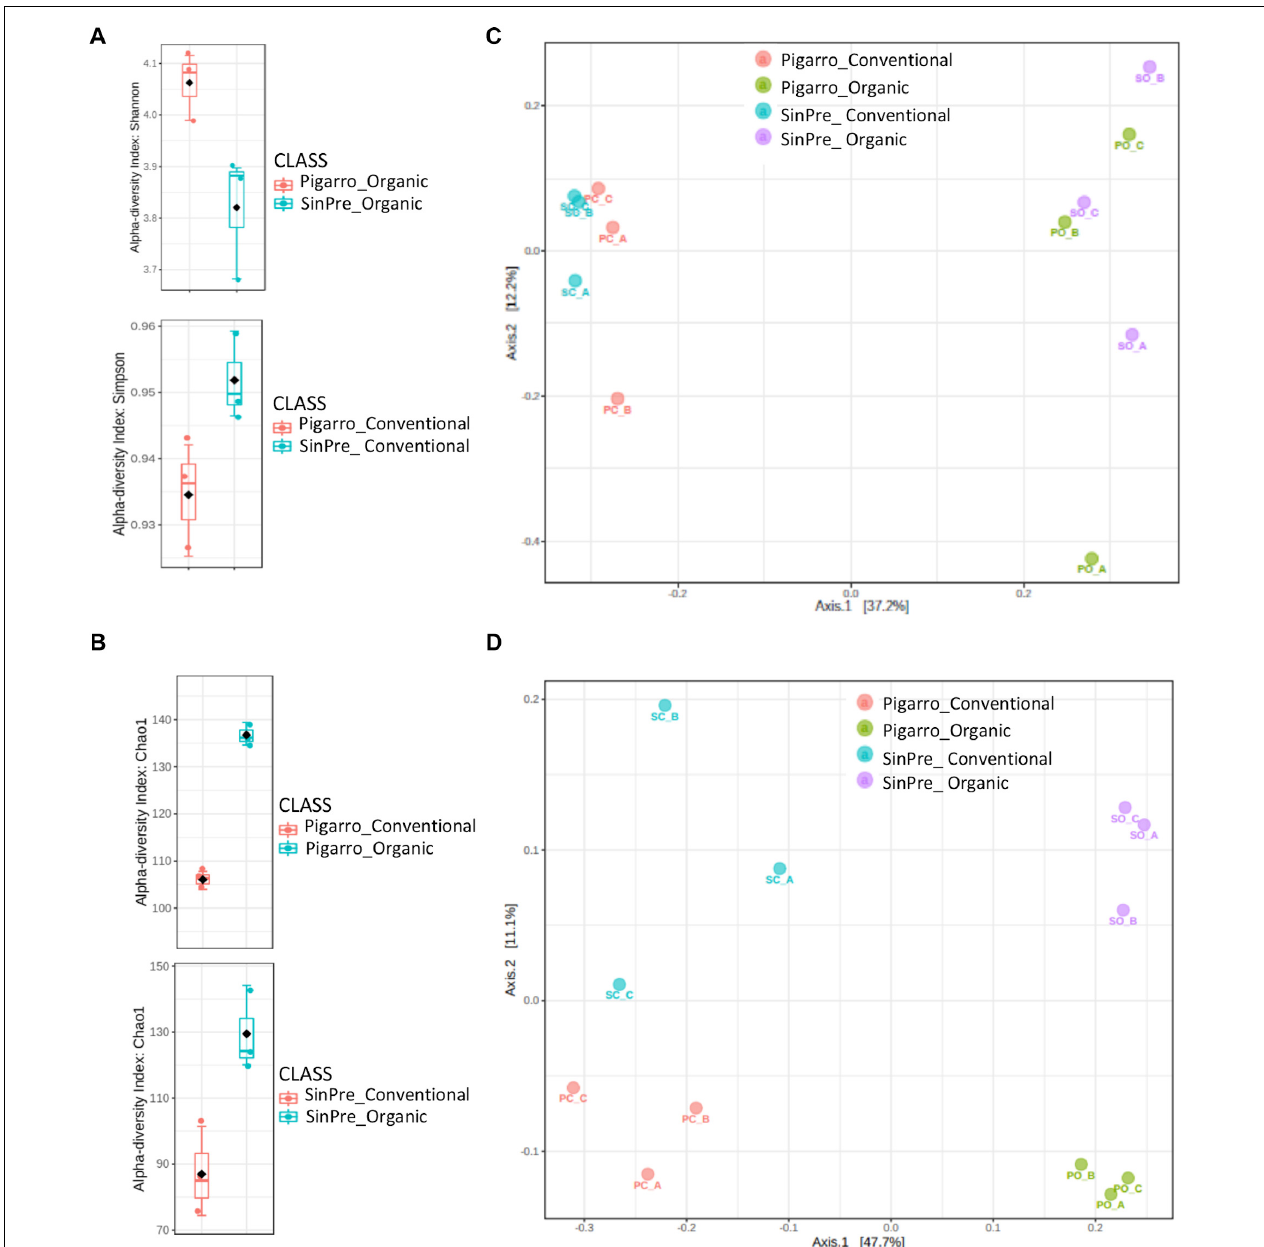
FIGURE 3 | Box plot illustrating statistically significant α diversity measures of the effect of farming system in fungal (A) and bacterial (B) communities in the maize rhizosphere. Principal coordinate analysis (PCoA) was performed using the prcomp package to illustrate the effect of farming system on the fungal (C) and bacterial (D) communities in the maize rhizosphere. The calculation is based on singular value decomposition of the fungal and bacterial communities for the farming system. A greater distance between the two samples indicates low similarity. The percentage of variation is explained by component 1 (PC1) and by component 2